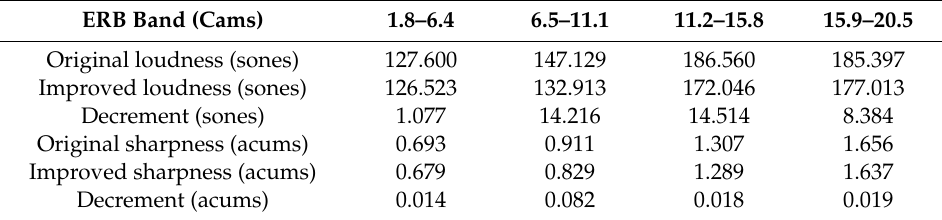
Table 5. Loudness and sharpness of sub-bands.